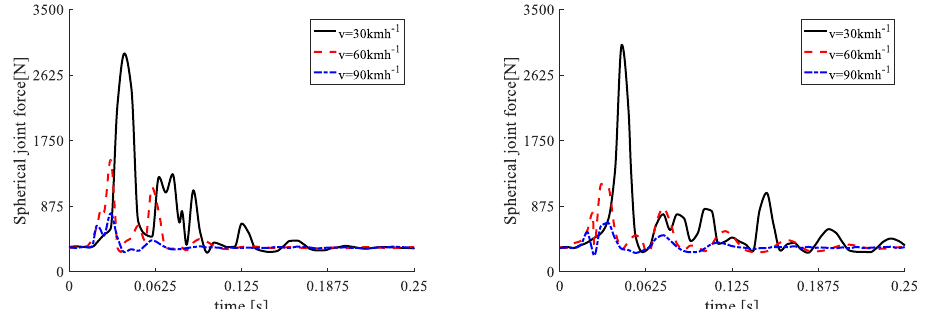
Figure 12. Selected time courses obtained for the suspension model with the twist beam during overcoming the U-type obstacle.